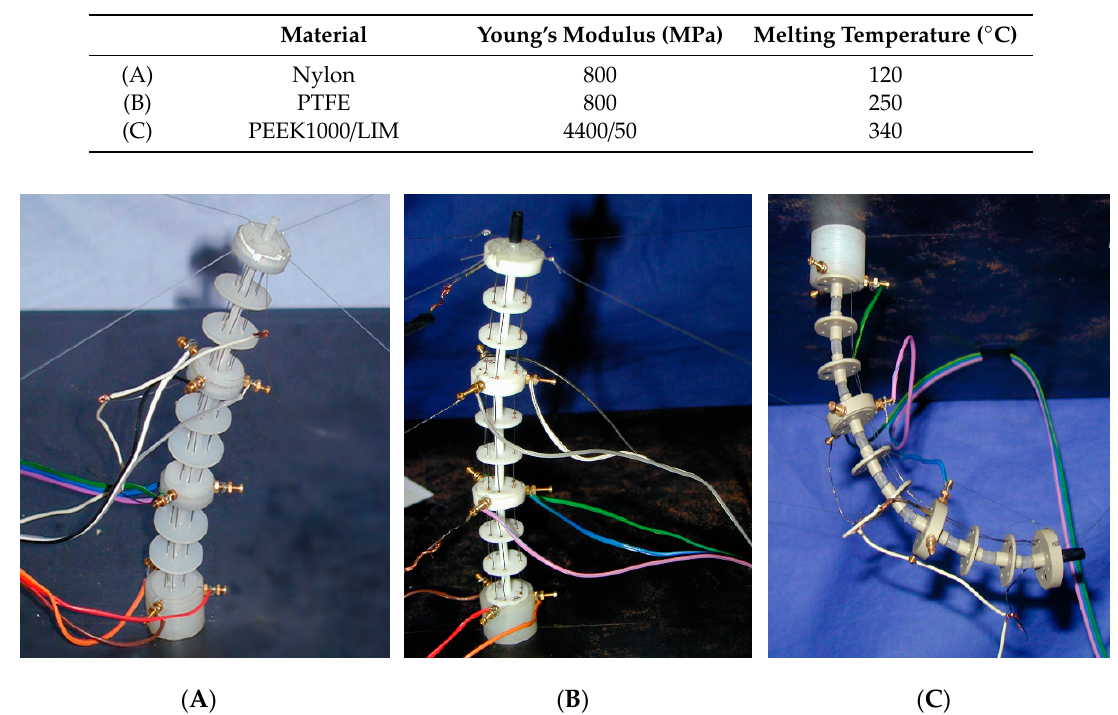
Figure 9. Prototypes A with nylon central rod ( A ), B with PTFE central rod ( B ), and C with LIM central rod and PEEK1000 disks ( C ).